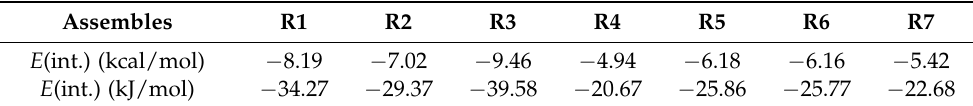
Table 3. Intermolecular interaction energies E (int.) of seven bimolecular